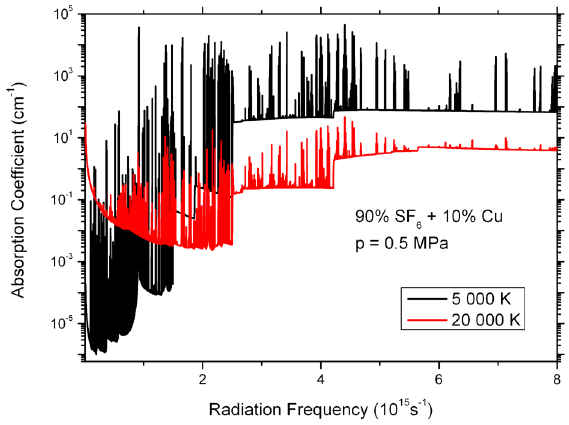
plasma with 10% Cu 6